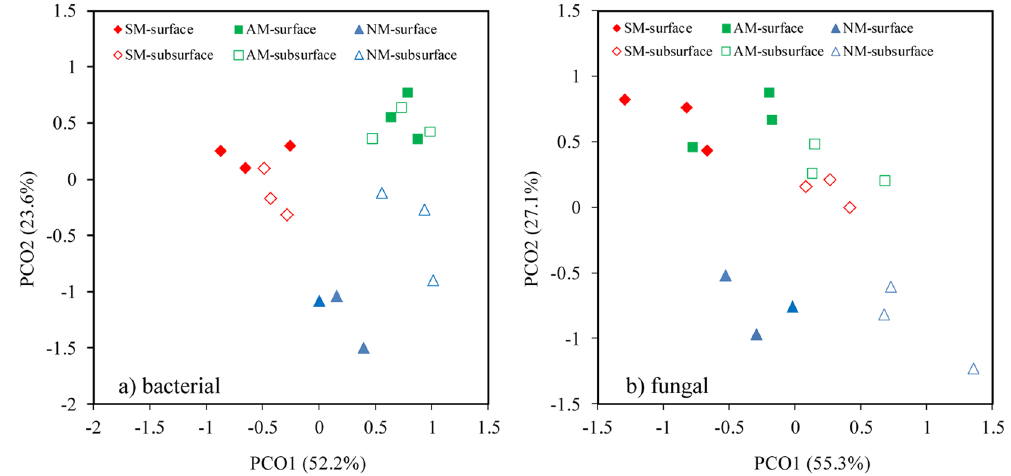
Figure 1. UniFrac-weighted PCoA plots of bacterial ( a ) and fungal ( b ) communities for different treatments in the two